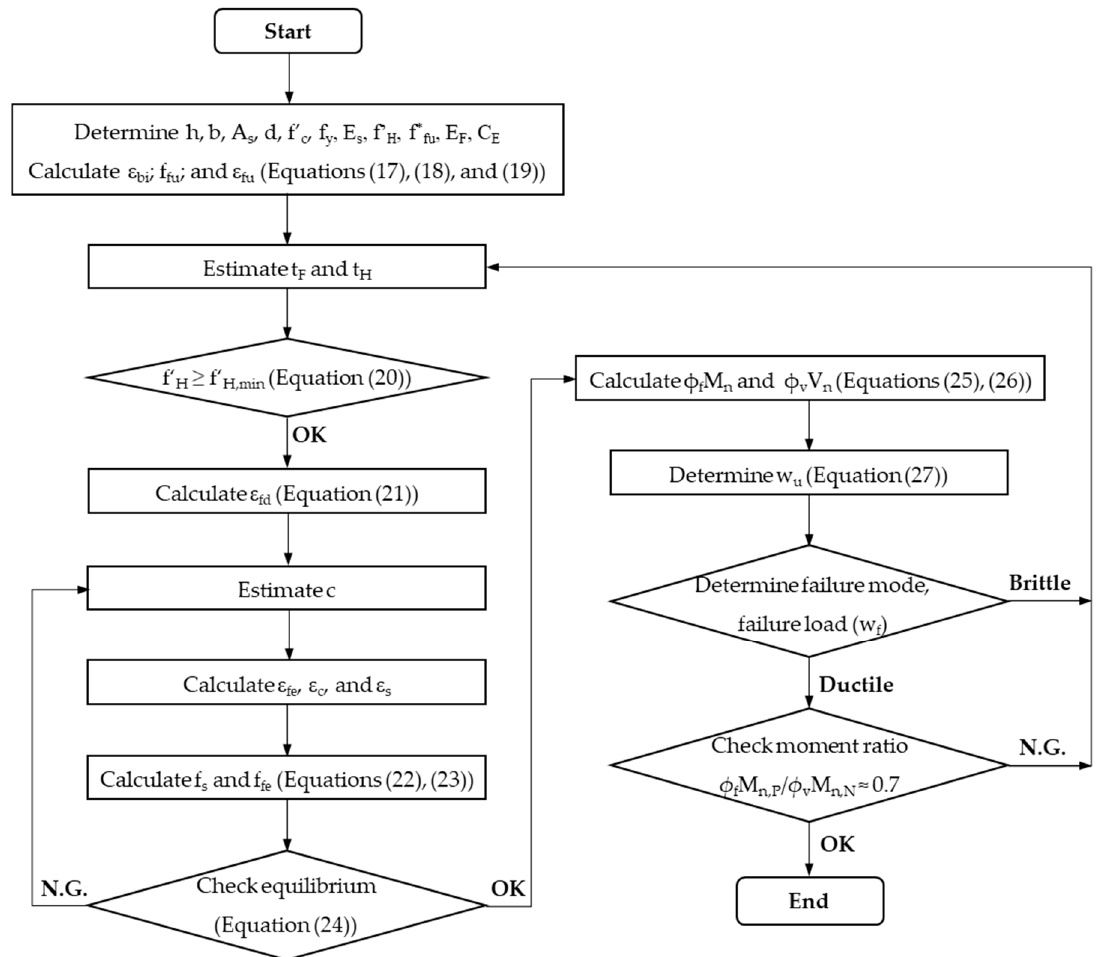
Figure 7. Design procedure flowchart for optimizing retrofit system.